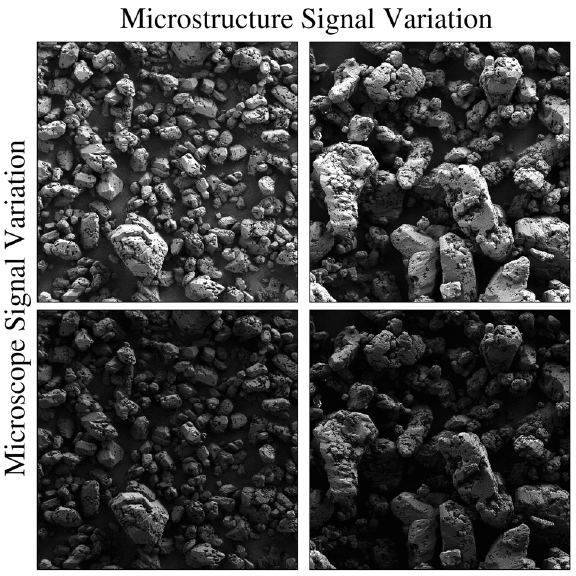
Fig. 1 SEM images showing signal variations. Images show variations from microstructure signals (column), derived from differences in microstructures of the samples and microscope signals (rows), derived from instrument conditions and